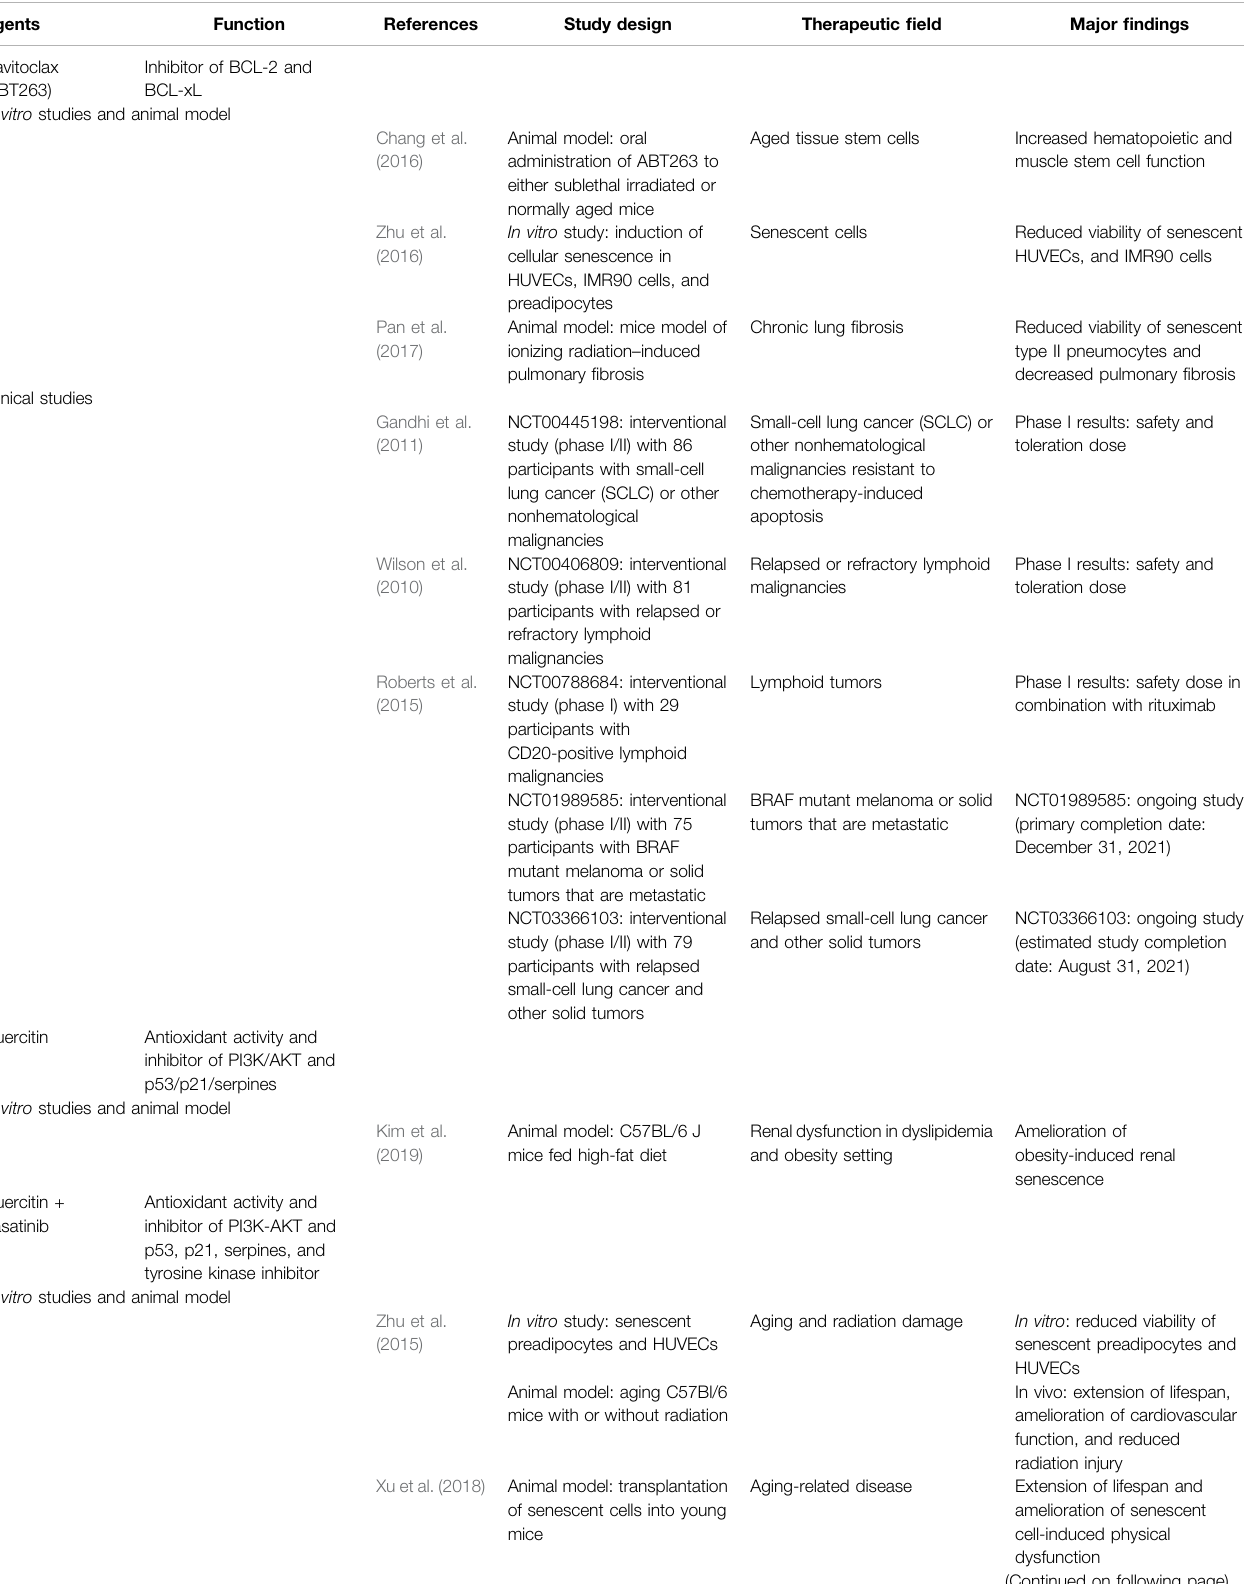
TABLE 1 | Senolytic and senomorphic